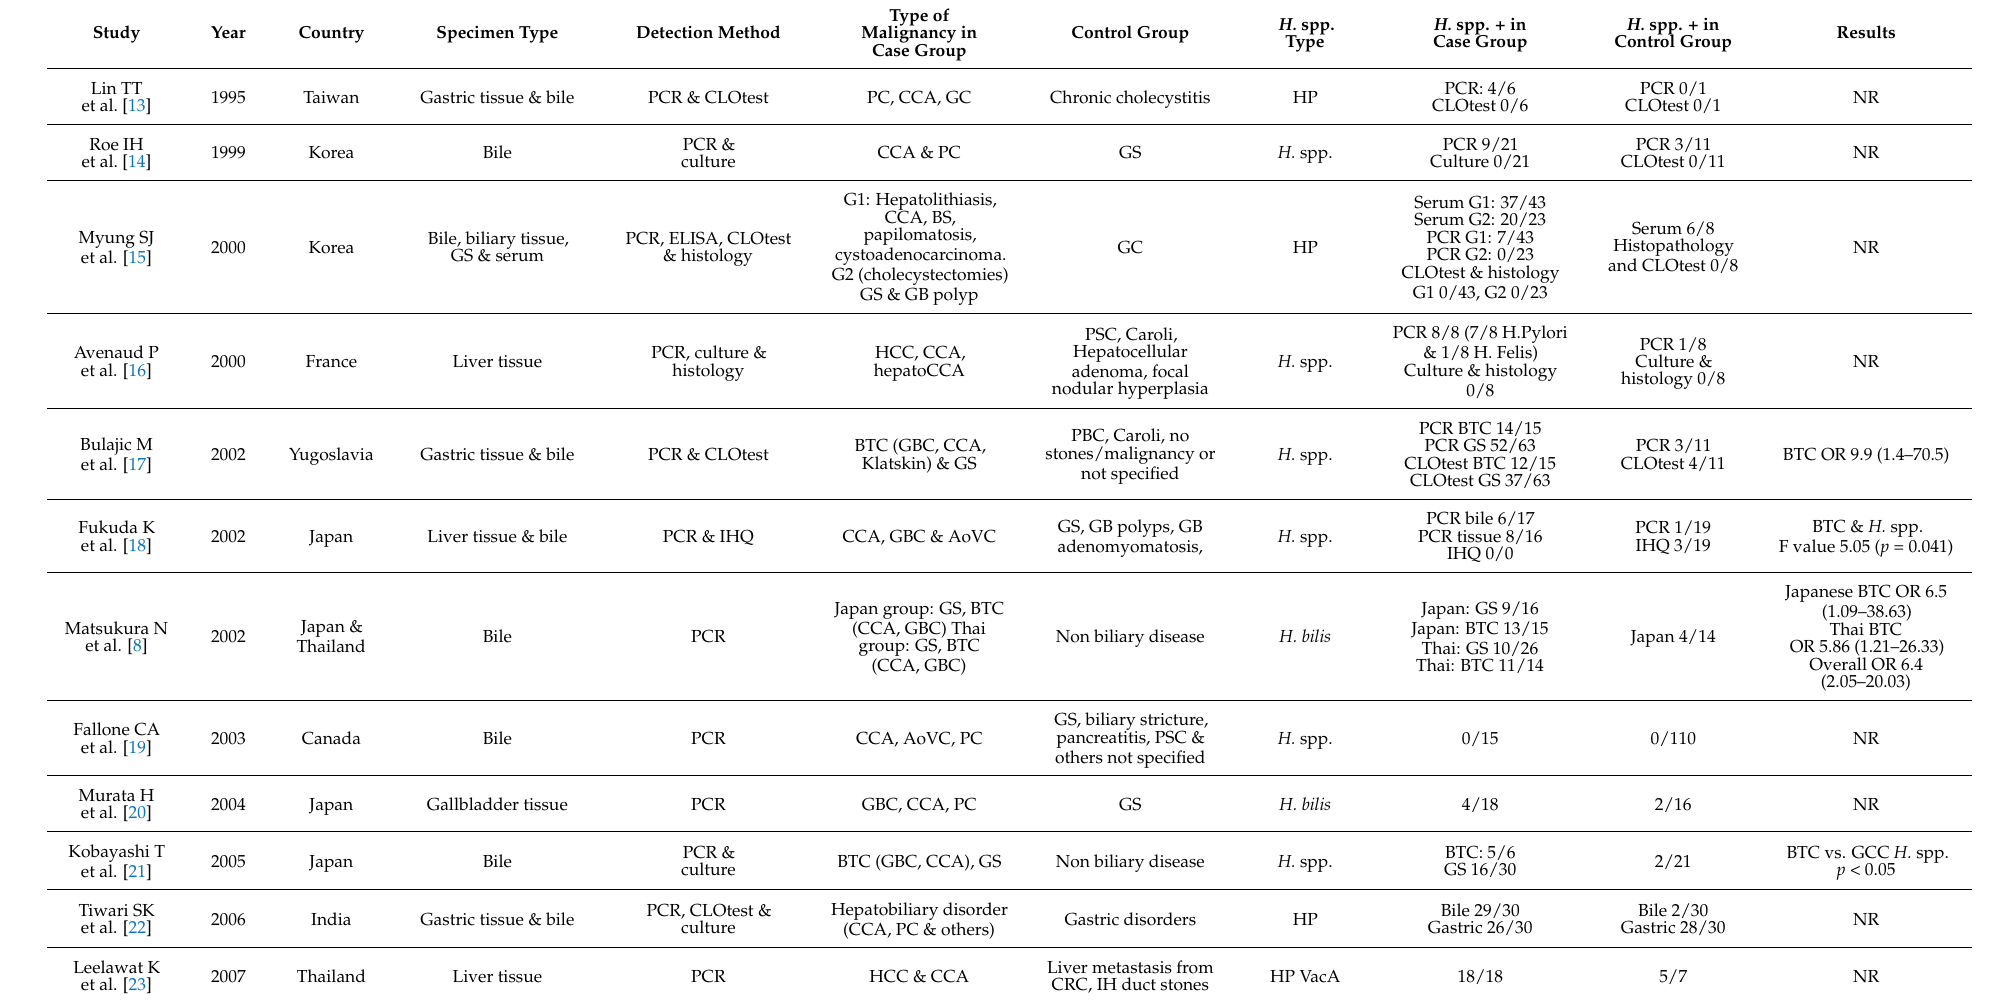
Table 1. Characteristics of the studies included in the systematic